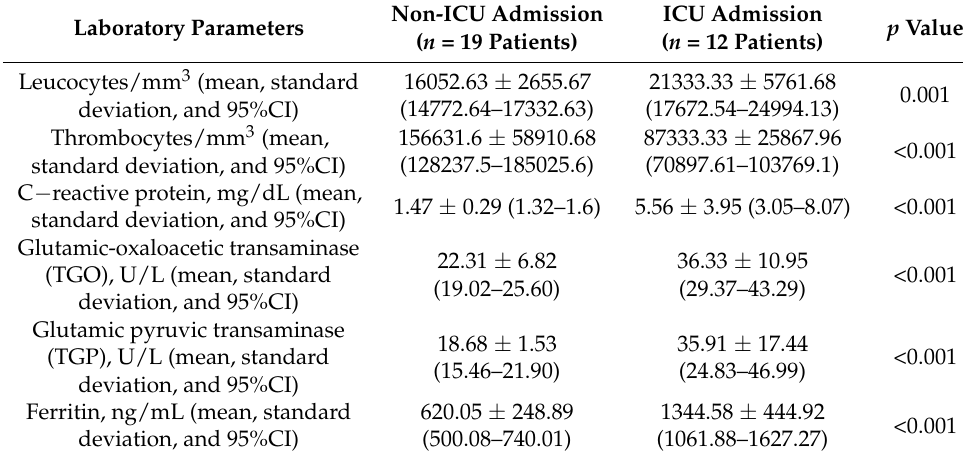
Table 3. A univariate analysis of the laboratory parameters for patients included in our